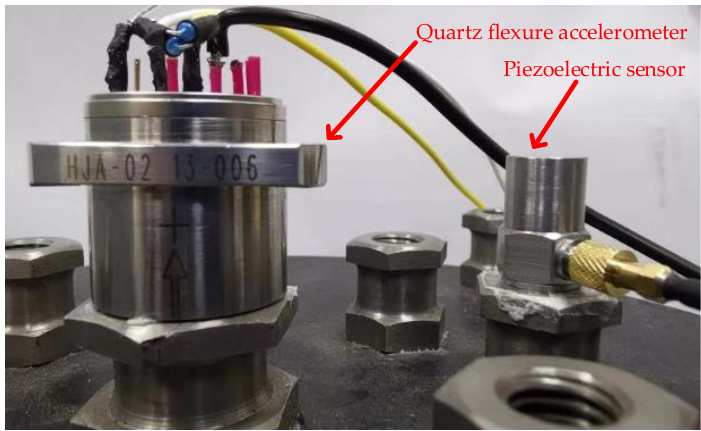
Figure 9. Experiment of the dual-sensor vibration measuring system.